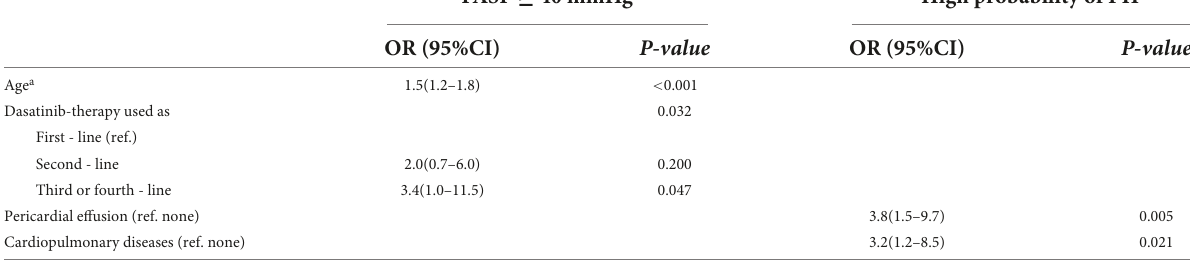
TABLE 5 Multivariable analysis of associated variables in longitudinal cohort.